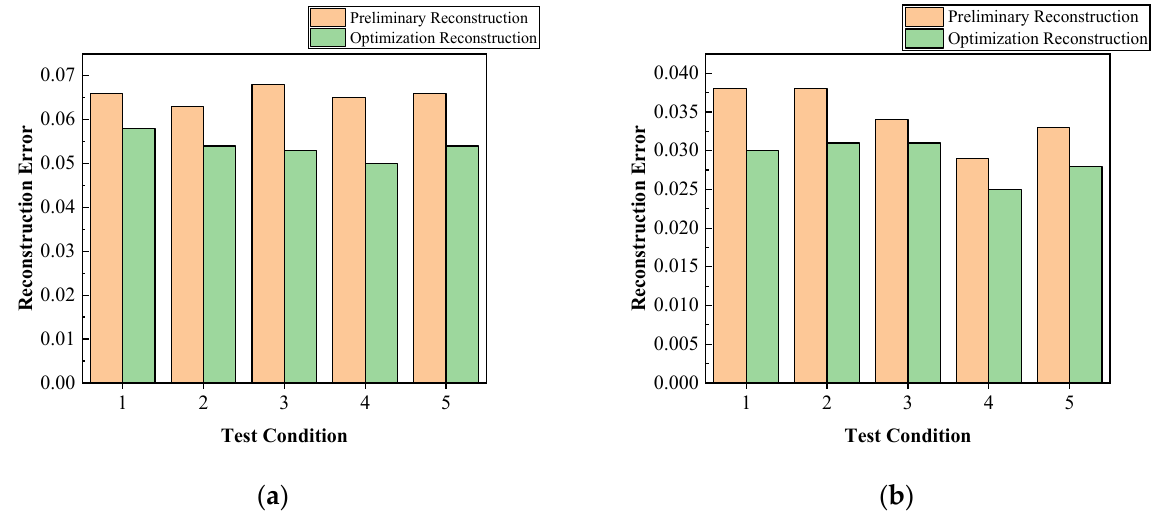
Figure 12. Optimized Effects of Reconstruction Algorithm with Noise: ( a ) SNR = 20; ( b ) SNR = 30.